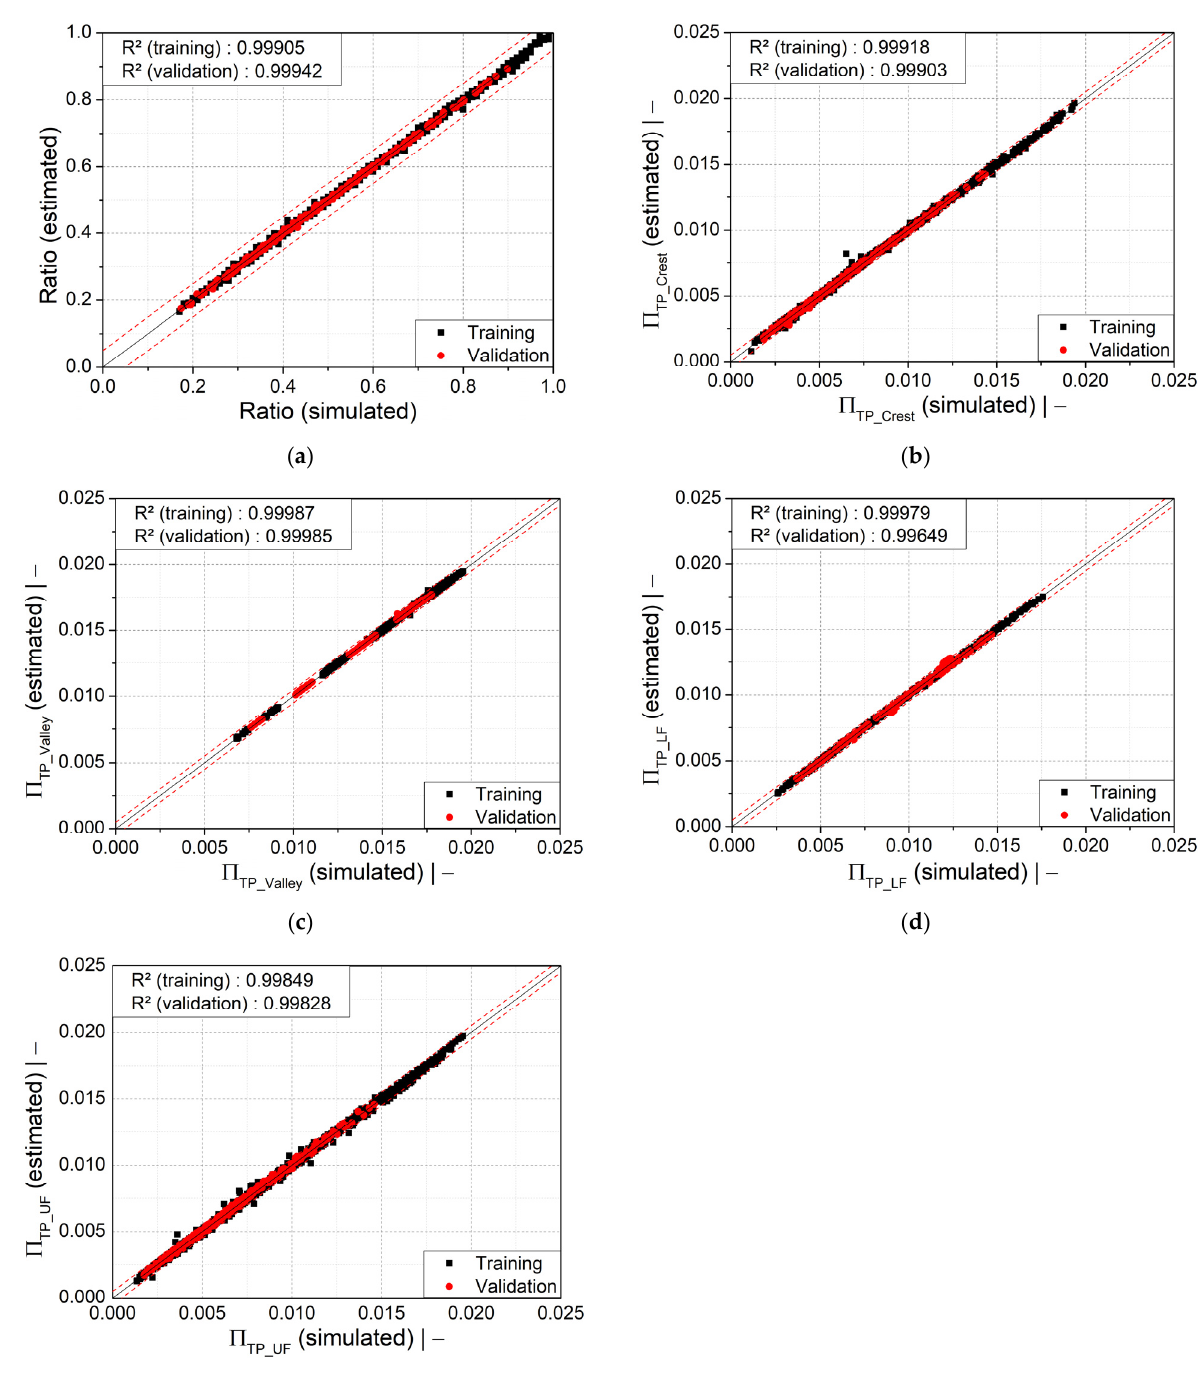
Figure 15. Scatter plots of ( a ) wall thickness ratio, ( b ) dimensionless wall thickness at the crest, ( c ) dimensionless wall thickness at the valley, ( d ) dimensionless wall thickness at the lower flank, and ( e ) dimensionless wall thickness at the upper flank. The dashed red lines indicate a relative error of ±